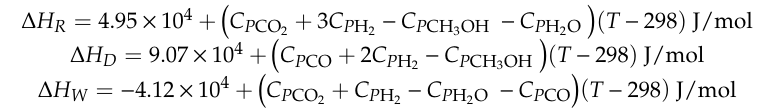
Table 3. Enthalpy change of reactions.